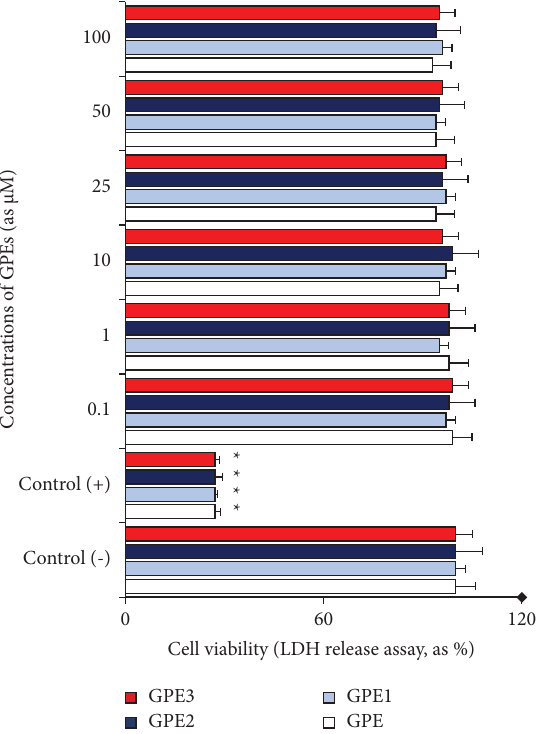
Figure 2: Te rates of PHWB cell viability after 72h exposure to diferent concentrations of GPEs. Te results were presented as a percentage of the control group ( n � 5). Data are expressed as mean ± SD p < 0 . 05 ∗